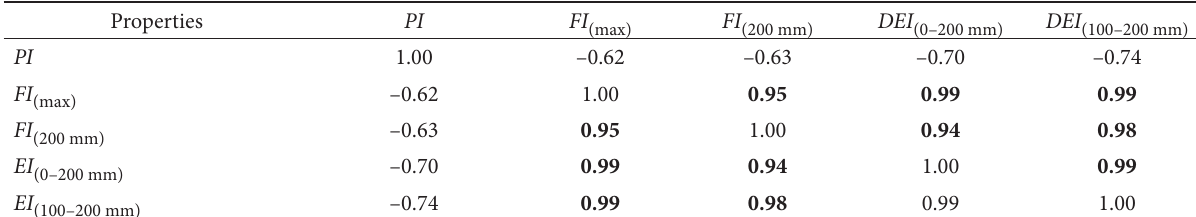
Table 9. The values of Pearson’s correlation coefficient R characterizing the relationships between temperature susceptibility coefficients of the tested asphalt